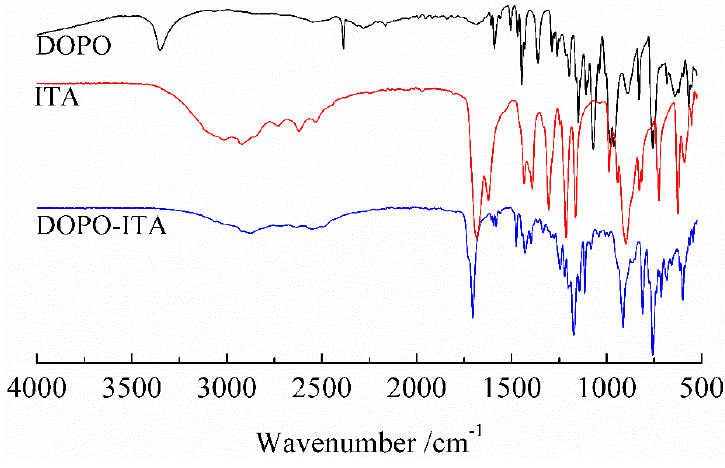
Figure 2. FT-IR of DOPO-ITA.